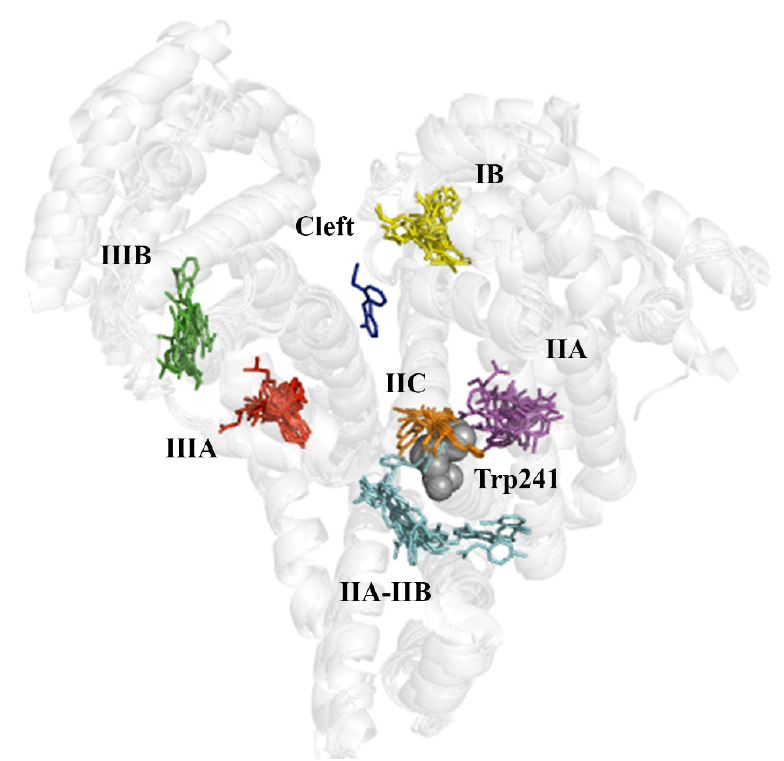
Figure 4. Representation of the main clusters observed for ( S )-ibuprofen, ( S )-naproxen, diflunisal, and NSAID-related compounds in the X-ray crystallographic structures of their complexes with albumin from different organisms. The protein backbone of selected albumins (PDB entries 2BXG, 6OCI, 4OT2, 4LUH, 6OCL, and 5OSW; see also Table 6) are shown as a light gray cartoon. The only tryptophan residue (Trp241) present in human serum albumin is shown as gray spheres. Ligands bound to a common binding site are shown in different colors.